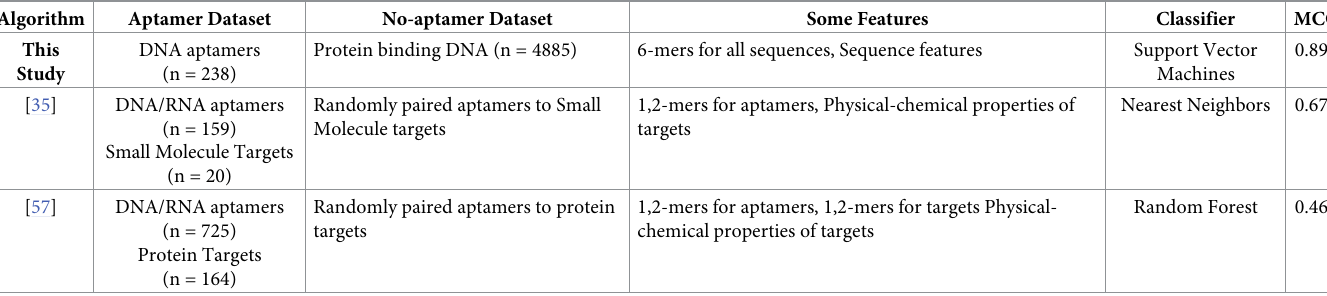
Table 1. Comparison of existing aptamer predictive studies.